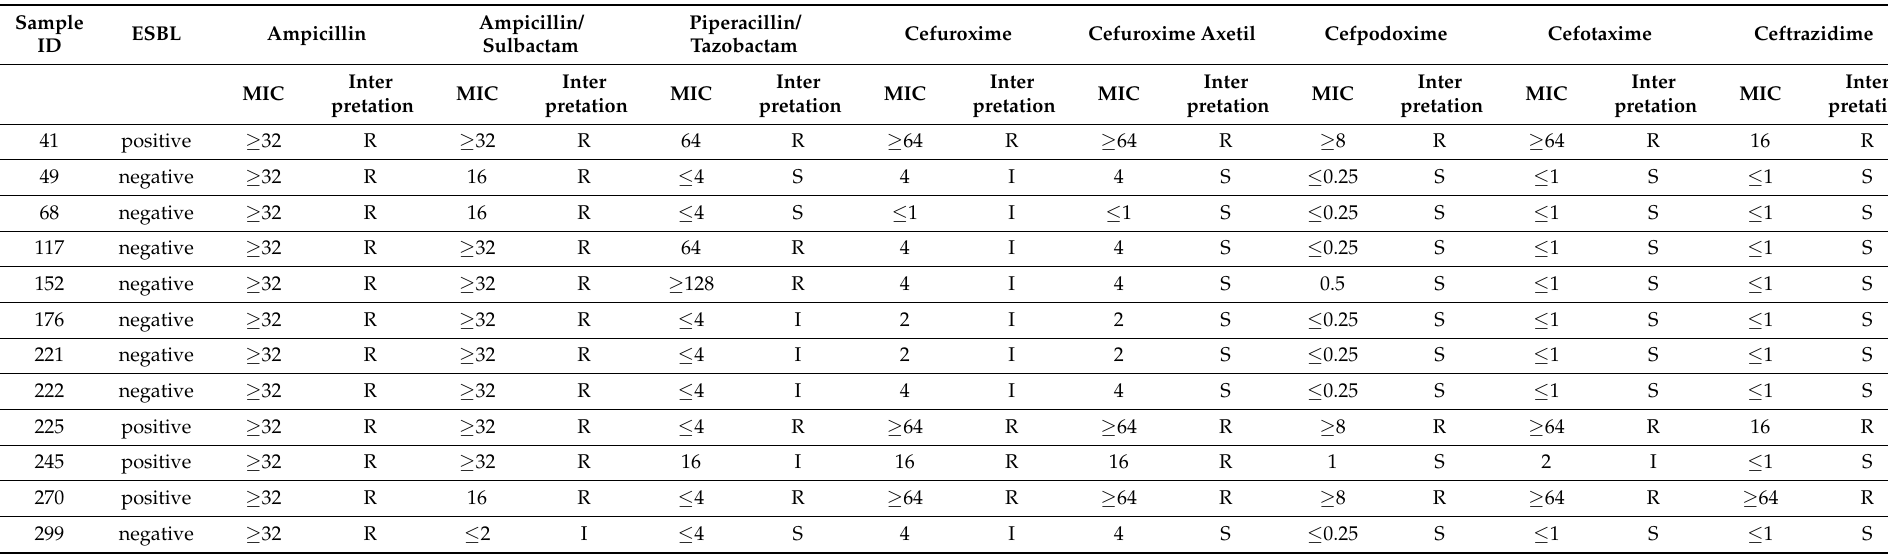
Table A7. Phenotypic resistance of Escherichia coli strains. MIC = minimum inhibitory concentration. ESBL = signal in phenotypic testing for extended-spectrum